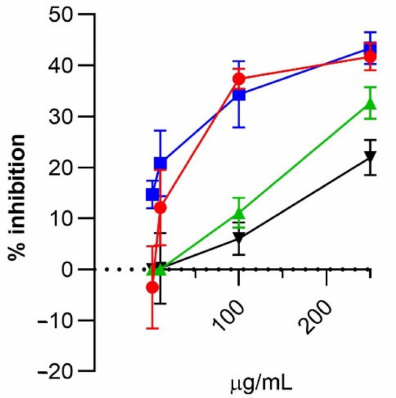
Figure 7. Dose-dependent anti-inflammatory activity of the four extracts. Extracts ranging from 1 to 250 µ g/mL were incubated with R3/1 cells transduced with the NF-kb reporter gene and challenged with 0.01 µ g/mL of IL1 α . Results are reported as % inhibition of luciferase signal in respect to control cells. Symbols: • extract A; (cid:110) extract B; (cid:78) extract C; (cid:72) extract D. Statistical analysis: ANOVA followed by Dunnett’s multiple comparisons test. The % inhibition found for each concentration was compared in respect to the control (untreated